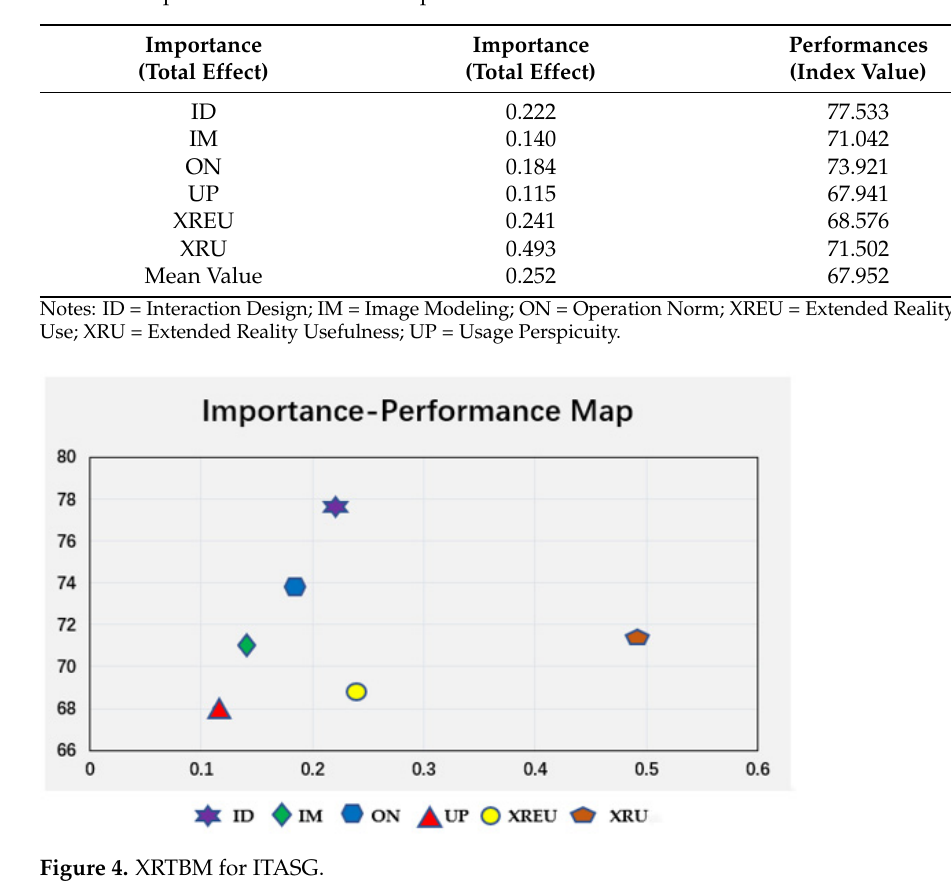
Table 11. Importance Performance Map Results.